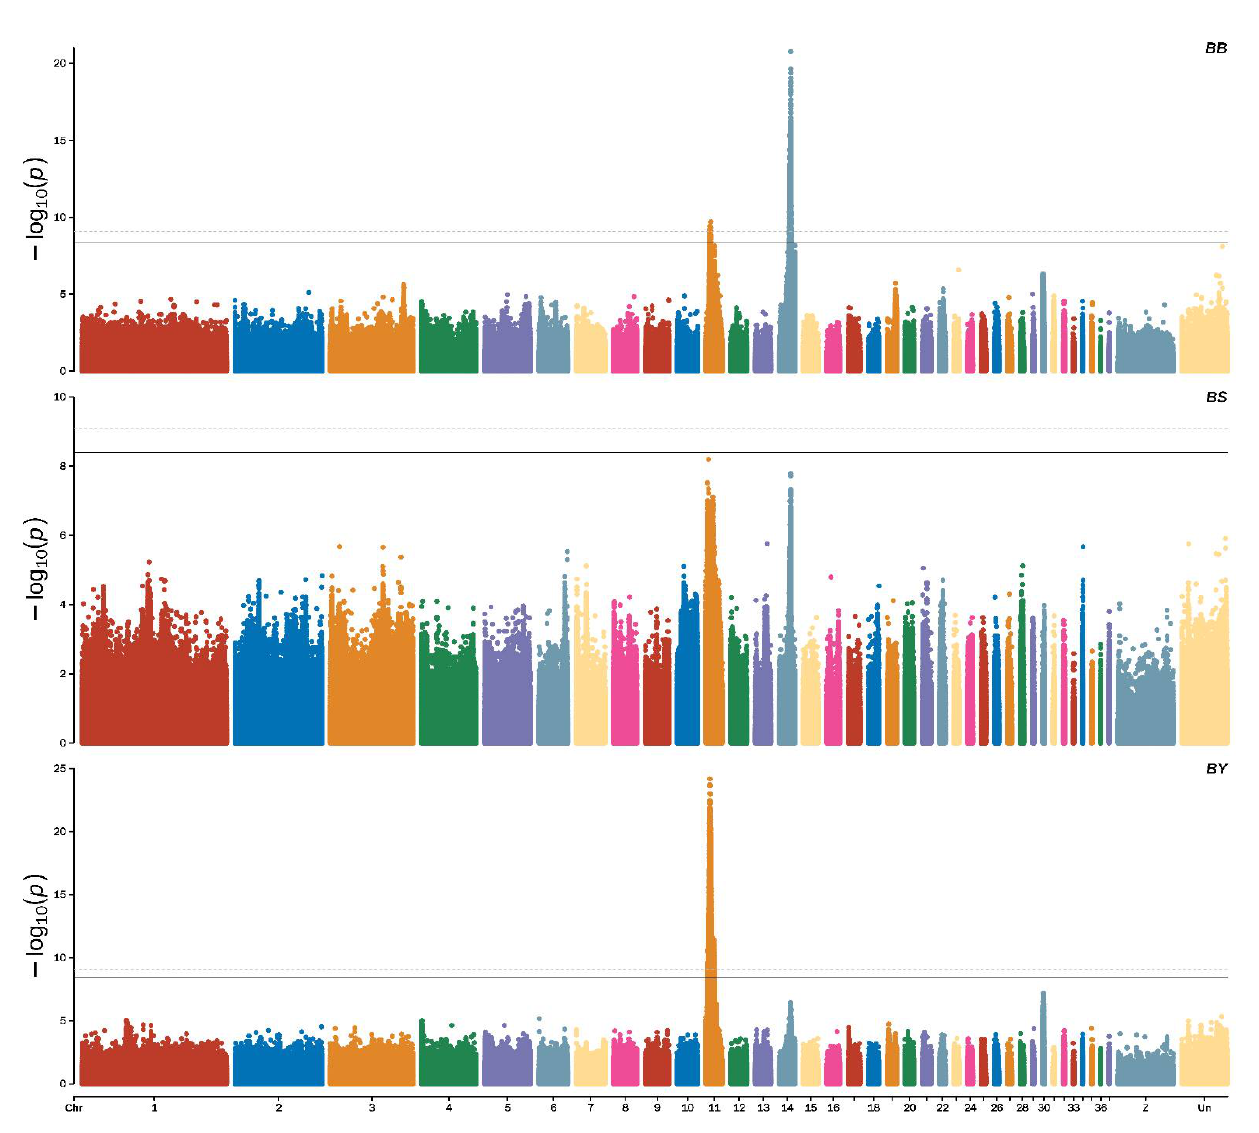
Figure 3. Manhattan plots showing the significance of genetic effects on the beak color according to the GWAS.